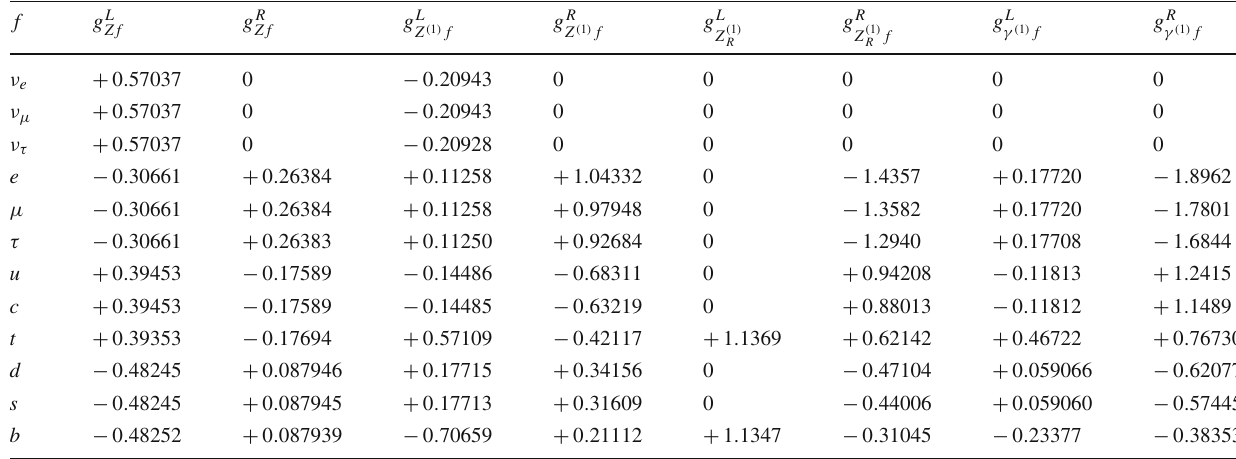
Table 3 Couplings of neutral vector bosons ( Z (cid:3) bosons) to fermions in unit of g w = e / sin θ W for θ H = 0 . 10, c l , c q >